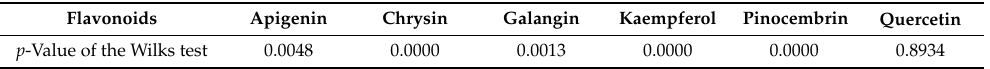
Table 7. The e ff ect of flavonoid concentrations in propolis extracts on antifungal activity.